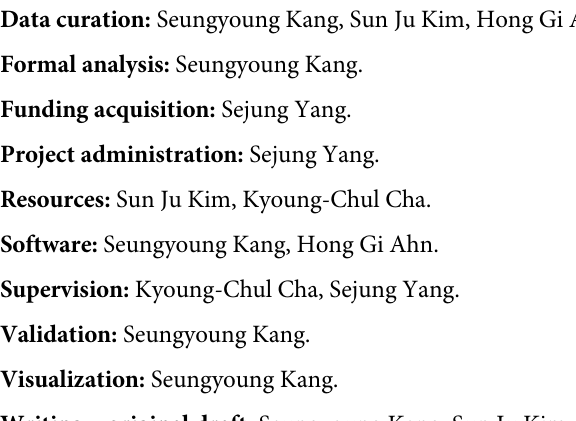
S1 Fig. The residual feature aggregation block architecture. The residual features that pass the enhanced spatial attention block are merged into one place. S2 Fig. (a) Block diagram of the residual block. (b) Enhanced spatial attention block. These blocks are contained in the residual feature aggregation blocks. S3 Fig. The results of statistical tests for data normality (Shapiro-Wilks test). S4 Fig. The results of statistical tests for data homoscedasticity (Bartlett’s test). S1 Table. The distribution of training, validation, and test datasets. S2 Table. Data distribution of five-fold cross-validation for deep learning. S3 Table. Formula of the